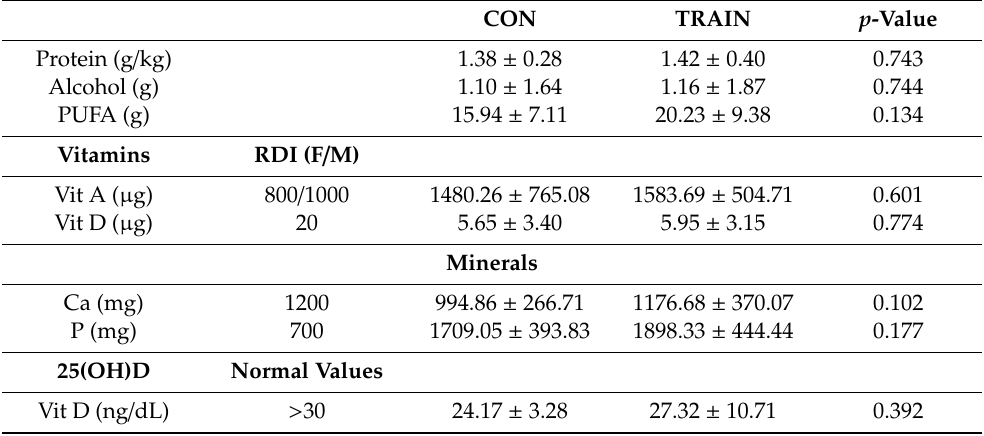
Table 4. Descriptive dietary intake variables per day from the semiquantitative food frequency questionnaire, serum 25(OH)D, and adherence to Spanish